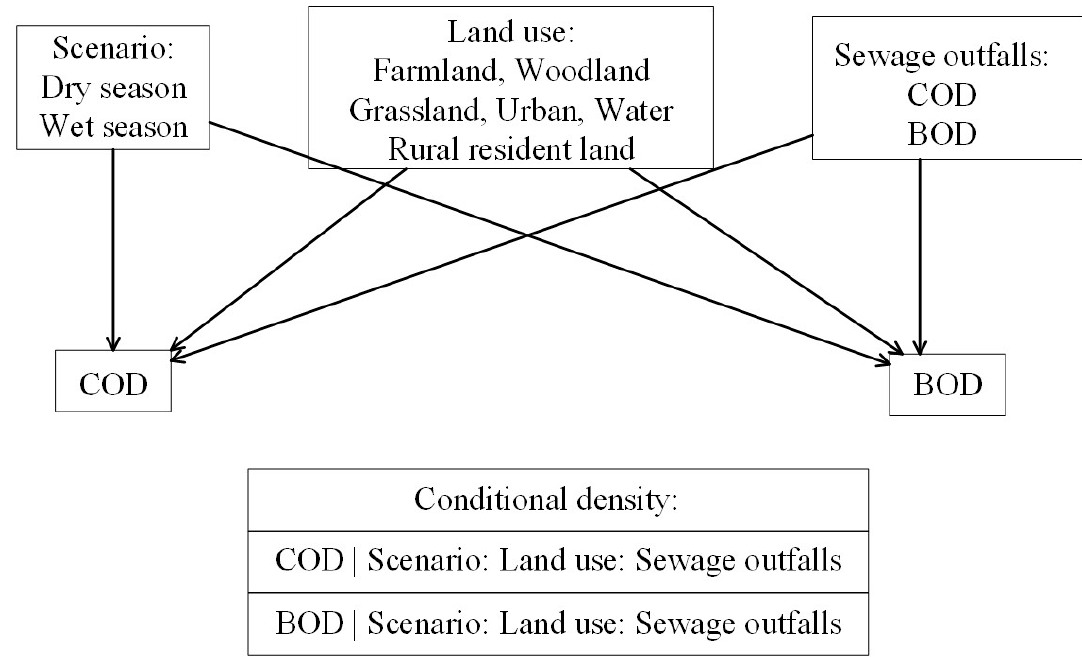
Figure 3. The Bayesian network (BN) structure, which describes chemical oxygen demand (COD) and biochemical oxygen demand (BOD) by season scenarios, percentage of land use types and amounts of contaminants from sewage outfalls in the HRB.